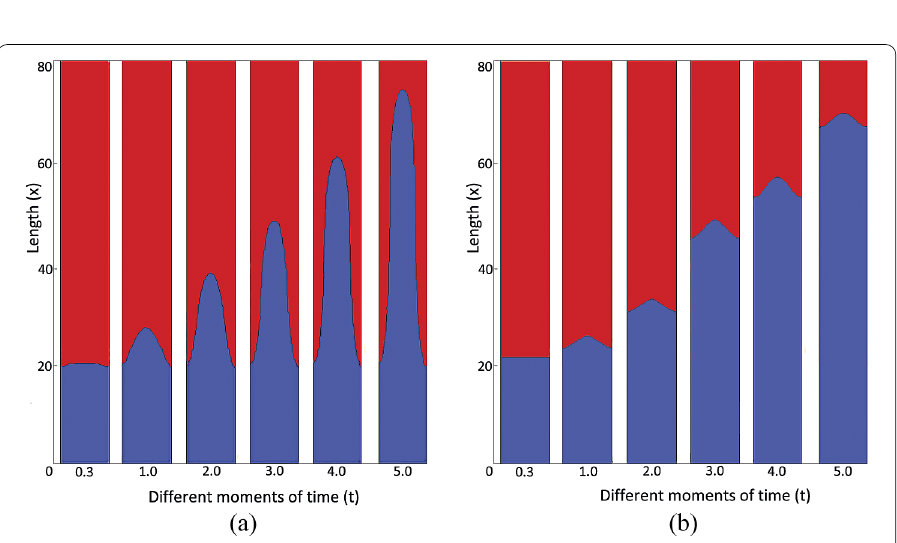
Figure 6 Displacement of oil ( ρ + = 1.1) by water ( ρ – = 0.86). (a) In an absolutely rigid solid and (b) in an elastic solid skeleton with the elasticity coefficient λ = 15. The contact points of the free boundary and solid body begin to move, and homogenization conserves the free boundary which separates the two liquids.